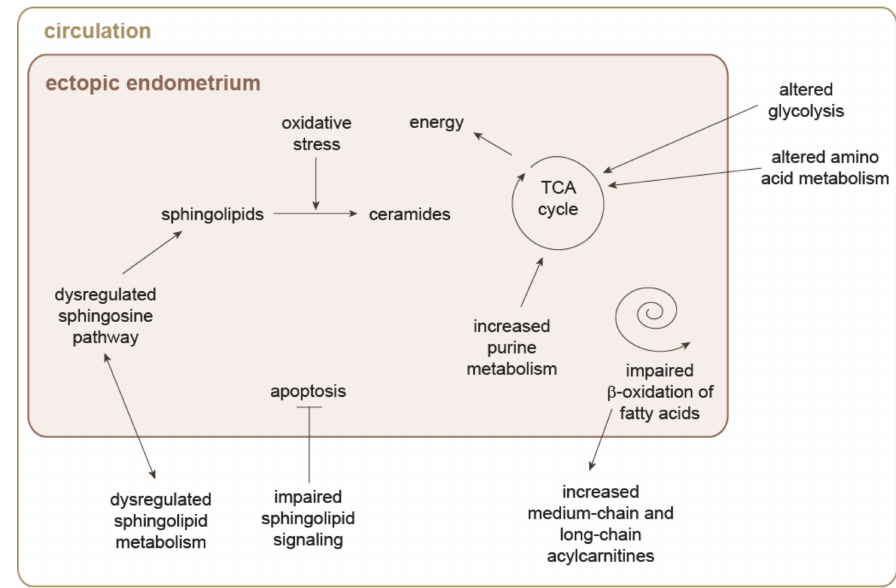
Figure 4. Speculative model of alterations in metabolic pathways in endometriosis, based on the identified biomarkers for endometriosis. Interactions between pathways and interactions between the endometrium tissue and the circulation were not experimentally validated in the studies included into this review. Arrows do not necessarily imply causal